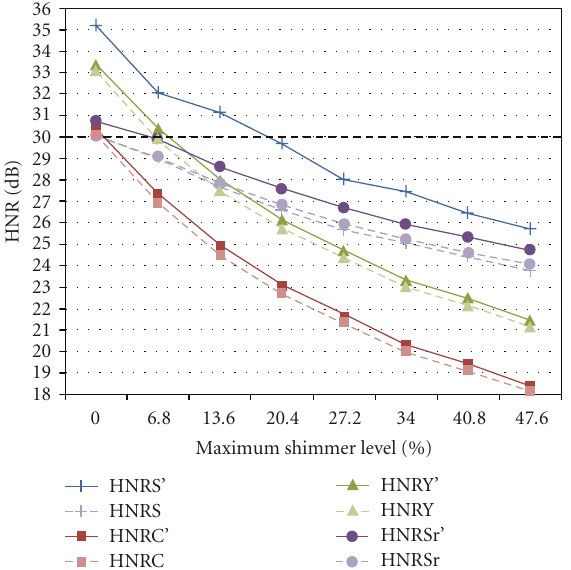
Figure 1: Results for the di ff erent HNR estimation methods. HNRY (in triangles) is the original formula in [9], HNRC (squares) the pulse number correction in [12], HNRS (plus signs) the shimmer correction proposed here (using known pulse amplitudes), and HNRSr (circles) the shimmer correction using estimated pulse amplitudes. Dashed lines represent results with AWGN; solid lines and apostrophes represent vocal tract filtered AWGN. Horizontal dashed line at 30 dB represents true